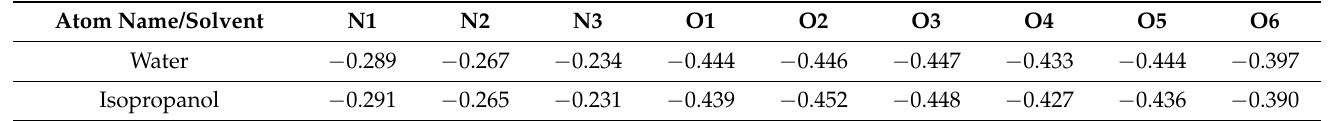
Table 1. Charge states of sorption centers in PBOI (in charges of electron, e).